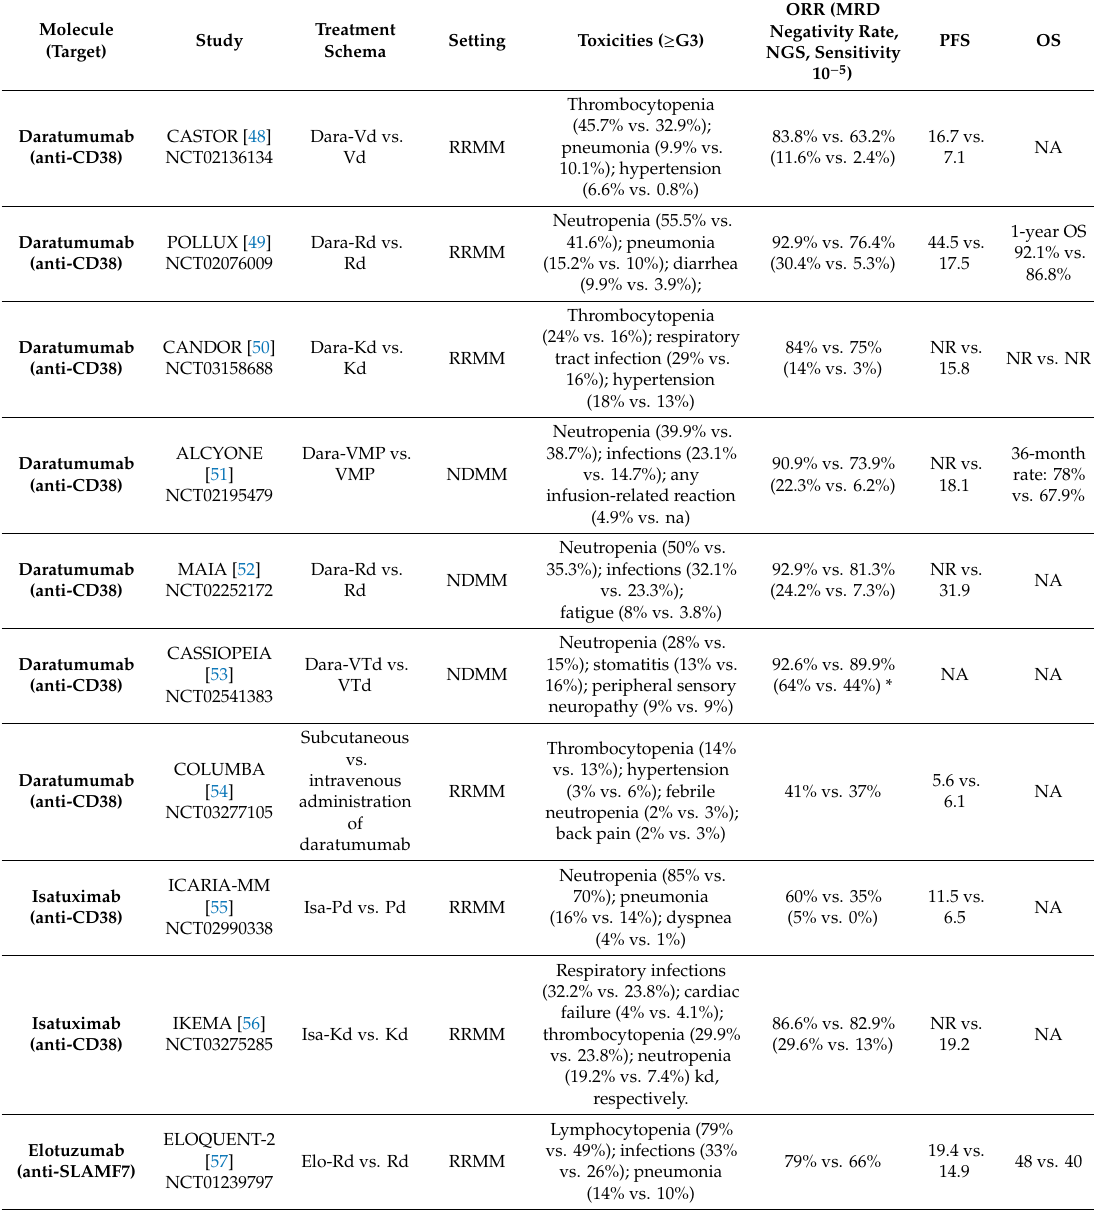
Table 2. List of phase III trials exploring naked mAbs in multiple myeloma